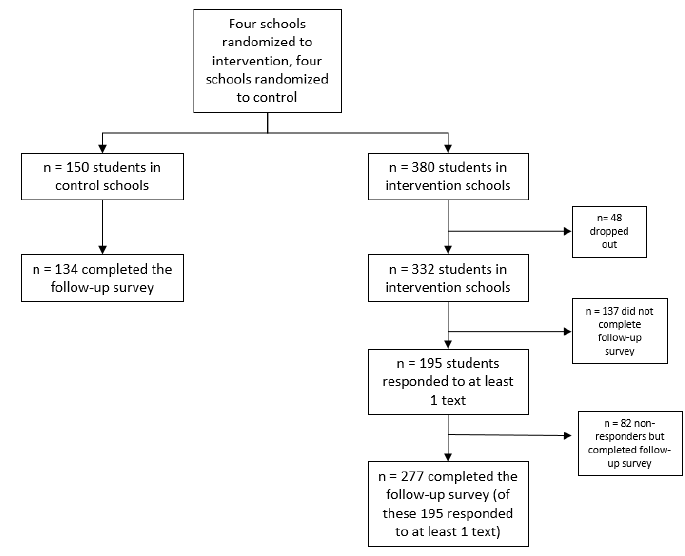
Figure 1. Student enrollment, drop-outs, and completers.